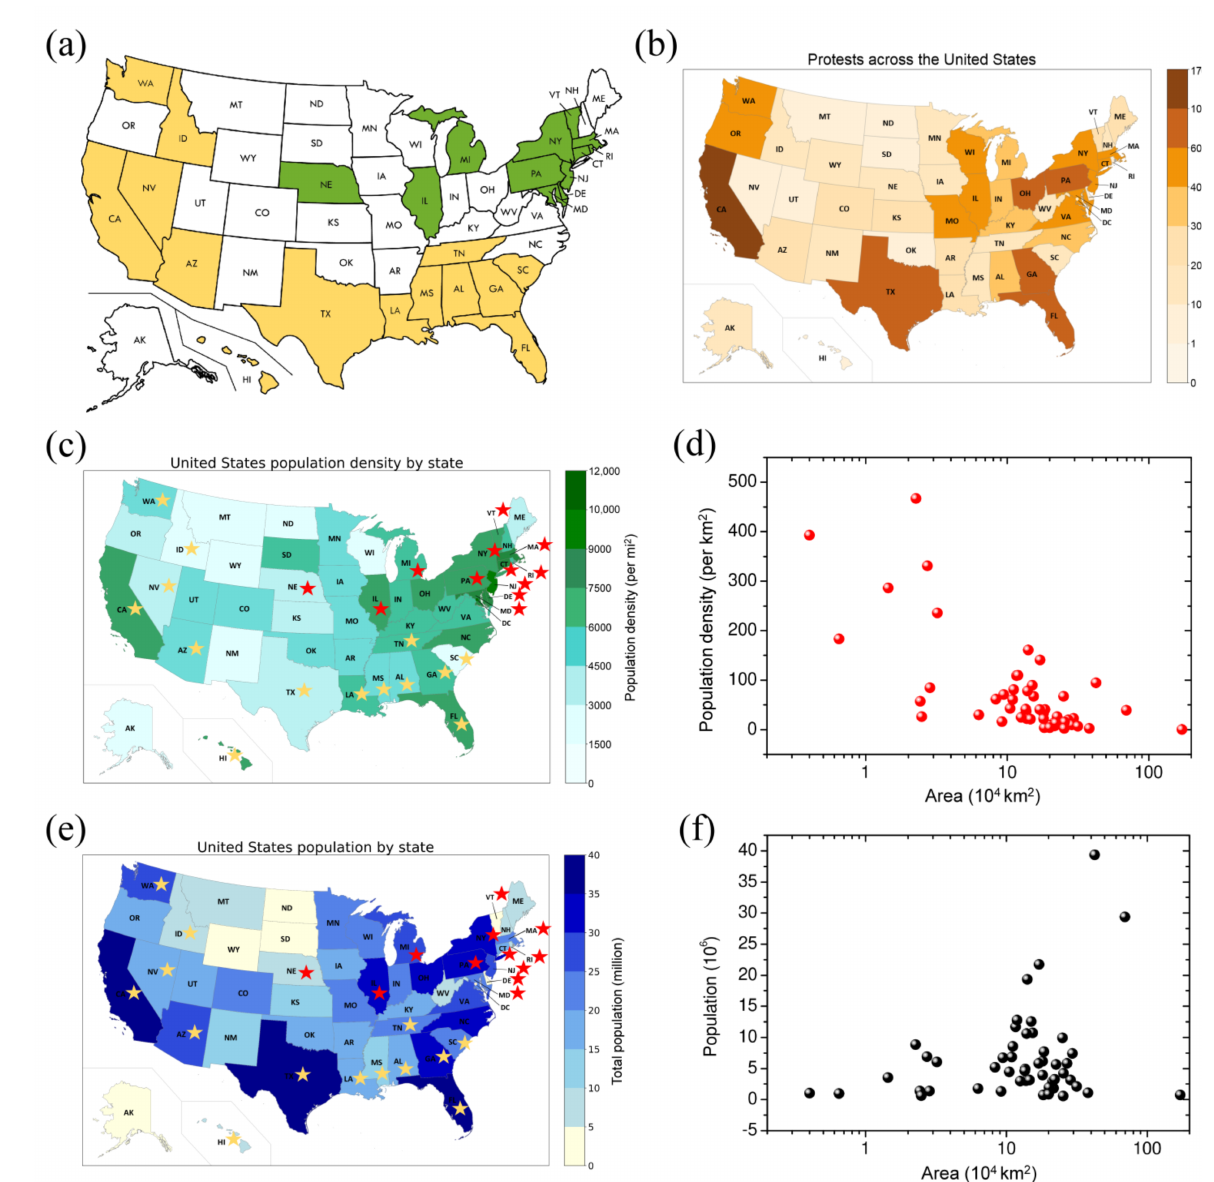
Figure 2. The color-coded maps of the US states. ( a ) The states with two epidemic outbreaks occurring in March–April and October–January are highlighted in green, and those with two epidemic outbreaks occurring in June–August and October–January are highlighted in yellow. ( b ) Protests across the US by the number of cities and towns with rallies or protests in a state, the data for which were taken from https://www.usatoday.com/in-depth/graphics/2020/06/03 /map-protests-wake-george-floyds-death/5310149002. ( c ) Population densities and ( e ) populations of the states with two epidemic outbreaks occurring in March–April and October–January are indicated by a red star, and those with two epidemic outbreaks occurring in June–August and October–January are indicated by a yellow star. ( d ) The population densities vs. areas for the 50 states in the US. ( f ) The populations vs. areas for the 50 states in the